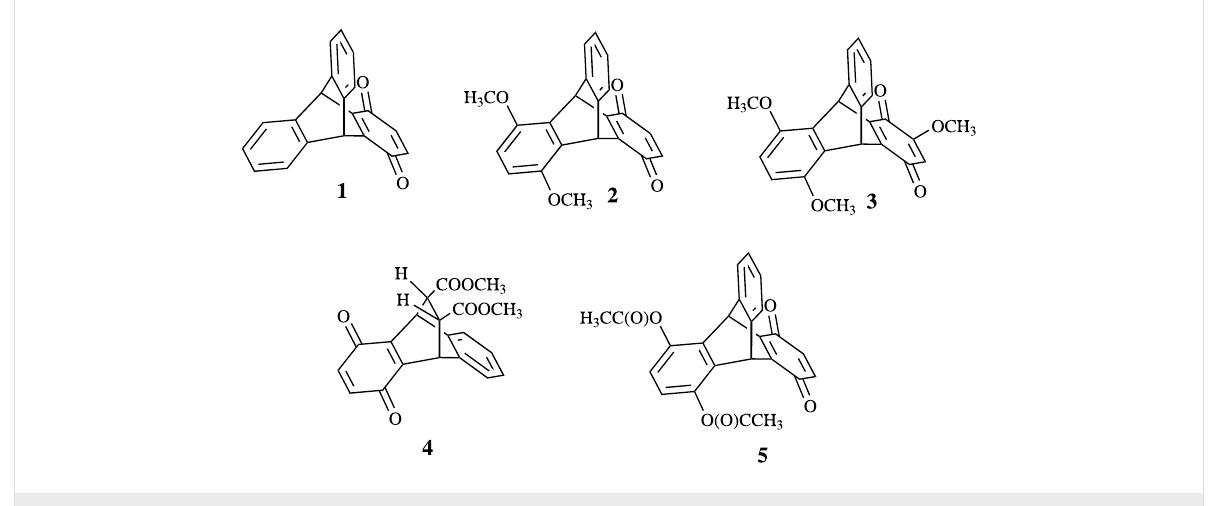
Figure 1: Bicyclic quinones explored for the transannular interaction.